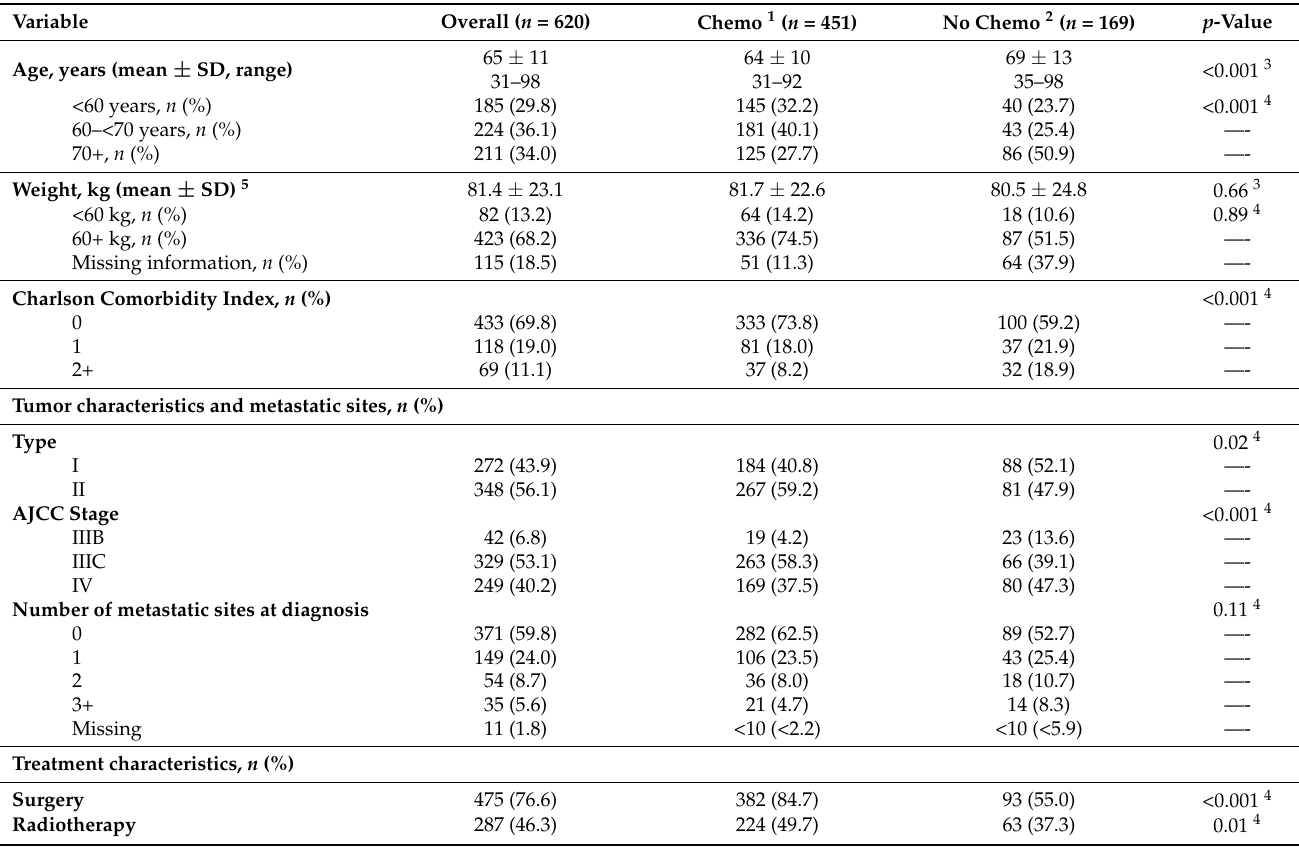
Table 1. Baseline and clinical demographics for advanced patients with EC, by receipt of